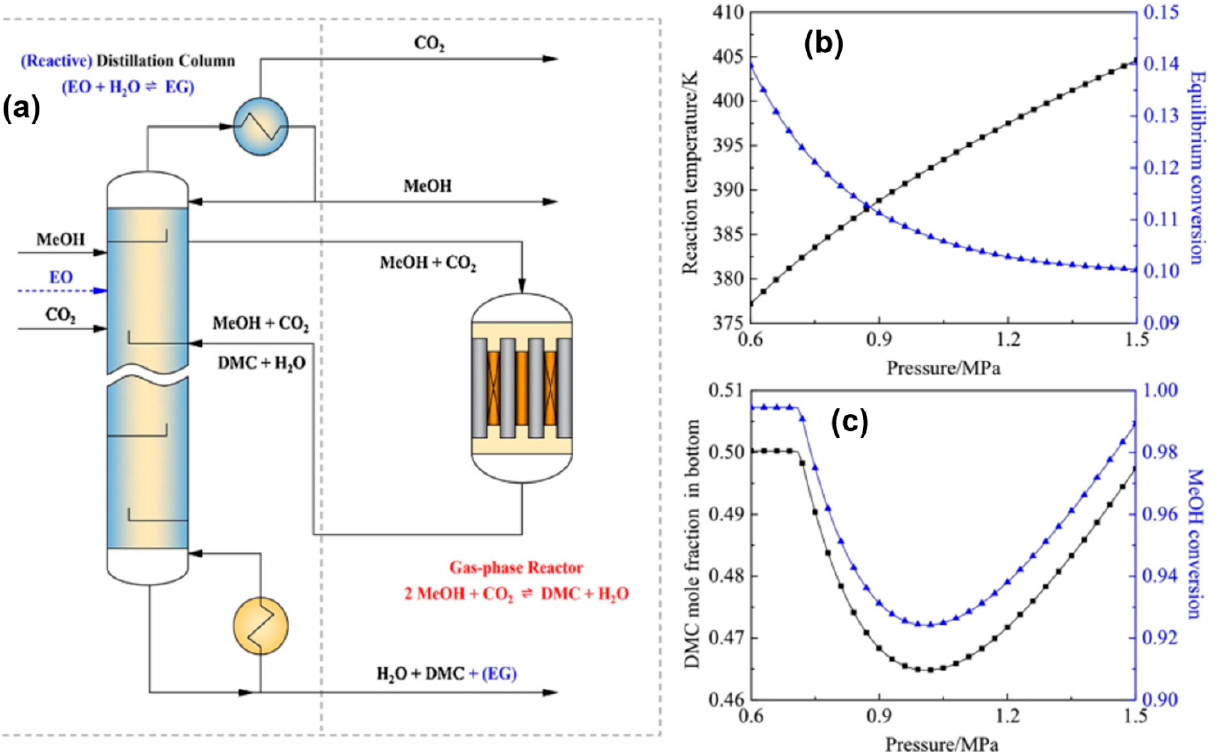
Figure 2. ( a ) Reactor with in situ hydration for green synthesis of DMC. Effect of pressure on ( b ) reaction and ( c ) reactive distillation. Reproduced with permission from Ref. [27]. Copyright 2018 Elsevier B.V.